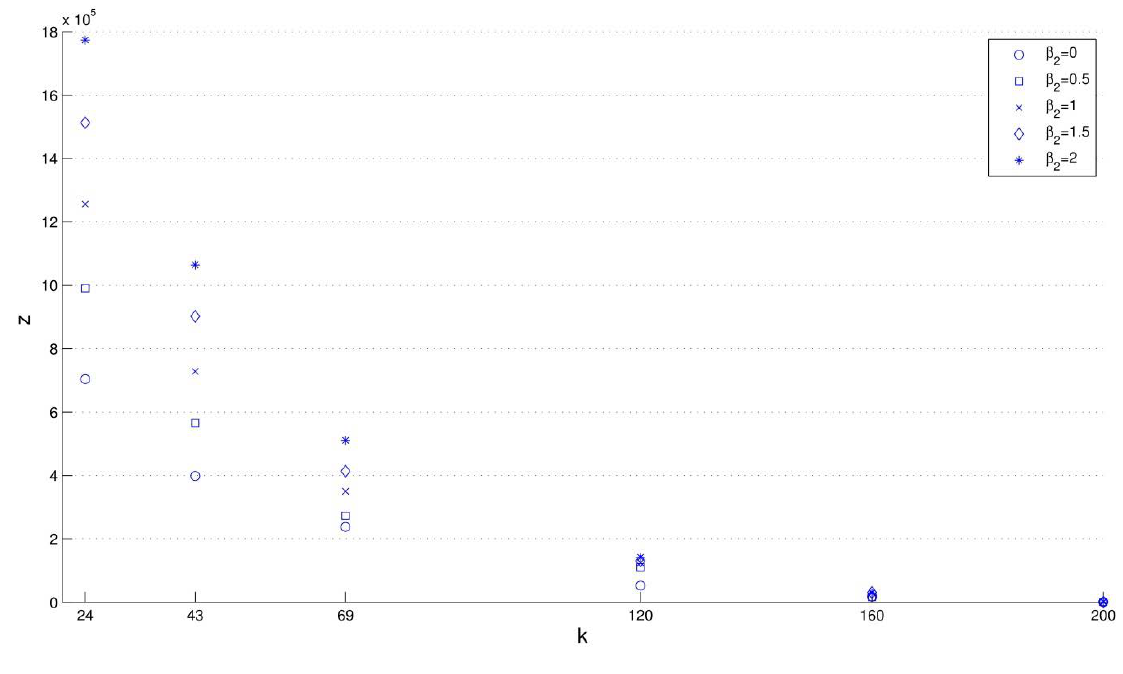
Figure 4. Objective function value when solving (13) with the greedy